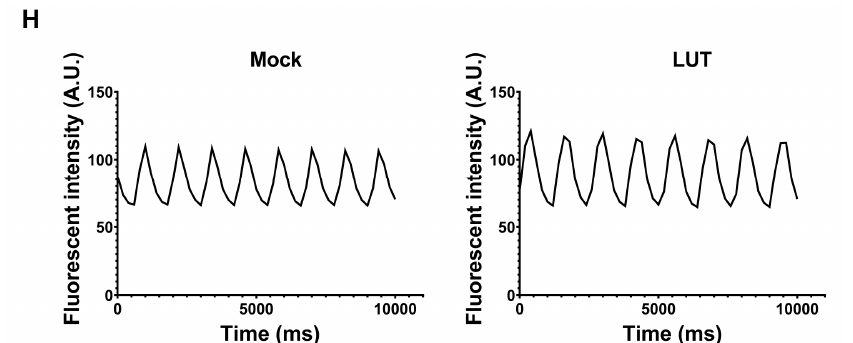
Figure 4. Normal functioning of hESC-derived cardiomyocytes after luteolin treatment. ( A ) Schematic diagram for procedure of cardiomyocyte differentiation. ( B ) Flow cytometry for CD172 α / β in hESCs or hESC-CMs after cardiomyocyte differentiation (No Ab: negative control without antibody, CD172 α / β Ab: CD172 α / β antibody) ( n = 2). ( C ) Graphical presentation of relative expression levels of pluripotency ( POU5F1, SOX2, NANOG ) and cardiomyocyte ( TNNT2, MYH7, NKX2-5 ) markers of hESCs and hESC-CMs ( n = 2). ( D ) Flow cytometry for CD172 α / β of hESC-CMs (No Ab: negative control without antibody, CD172 α / β Ab: CD172 α / β antibody). ( E ) Flow cytometry for Annexin V in hESC-CMs at 24 h after luteolin (LUT) treatment (12.5 μ M). ( F ) Microscope image of undifferentiated hESCs (left) and hESC-CMs (right) (scale bar = 200 μ m). ( G , H ) Graphical presentation of mean intensity of fluorescence of Ca 2+ in hESC-CMs; ( G ), with 24 h treatment of mock ( H : left) or 12.5 μ M of LUT ( H : right) ( n > 70).